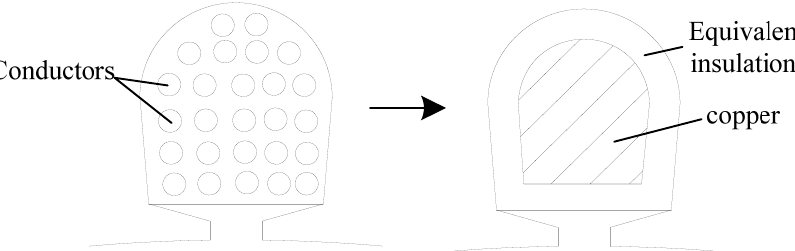
Figure 8. Equivalent process of the